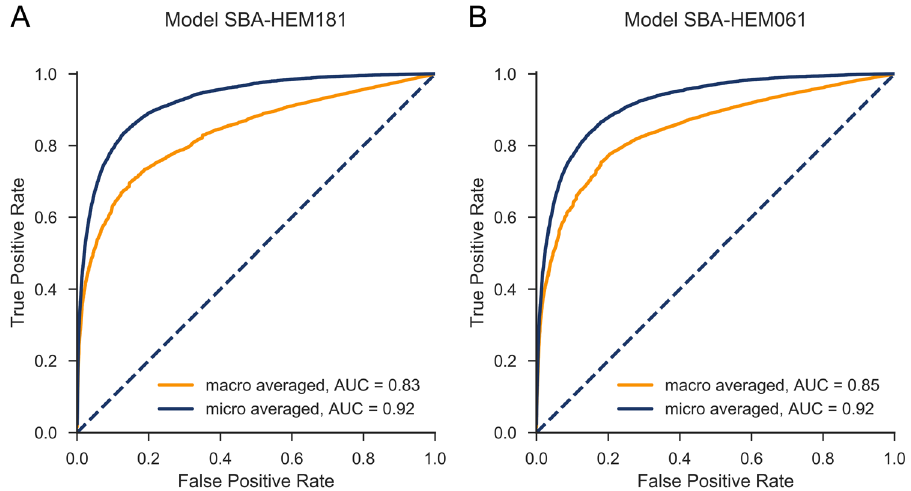
Figure 8. Macro- and micro-averaged ROC curves with ( A ) a full set of 181 parameters and ( B ) a basic set of 61 parameters. The curves almost overlap, and the AUCs are almost identical.